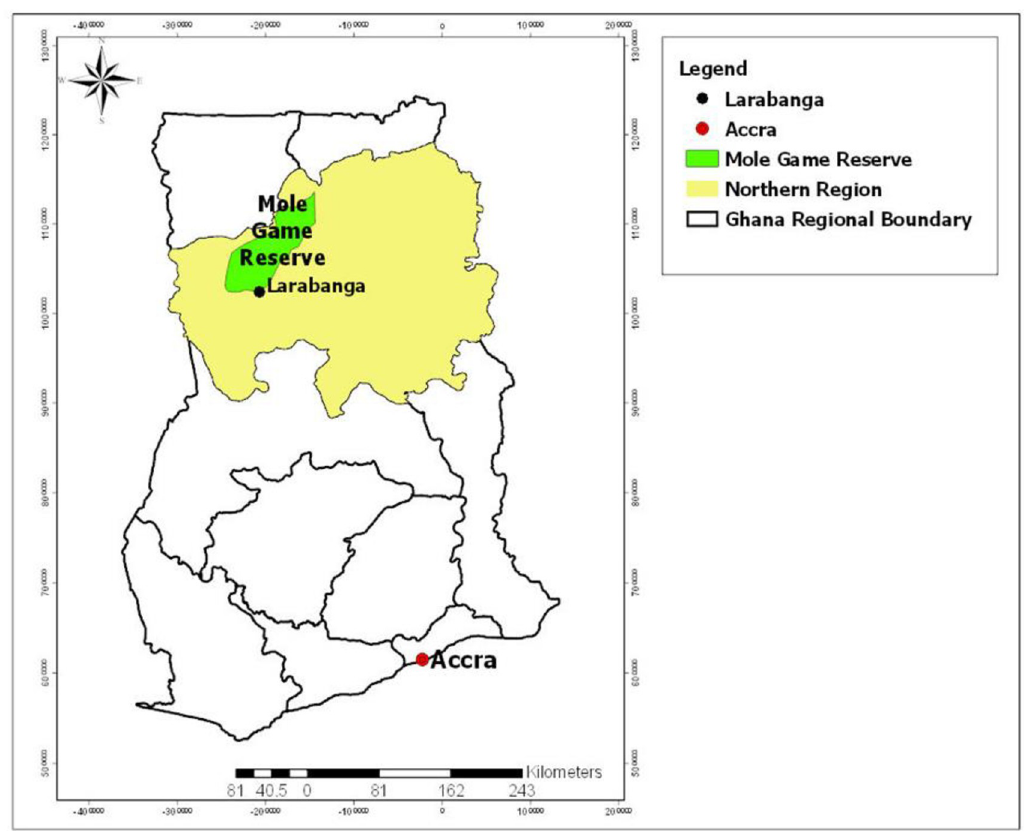
Fig 1. Map of Ghana showing the study sites. Map was developed using shape files of Ghana from the public domain repository of Natural Earth (http://www.naturalearthdata.com/) and built with ArcGIS.